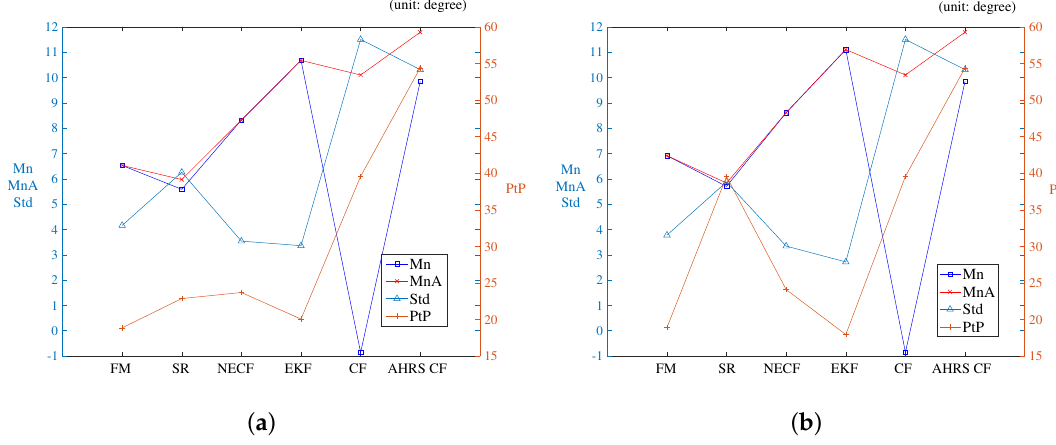
Figure 5. Average, average absolute error, standard deviation, and peak to peak of attitude error obtained with considered methods in experiment 1. ( a ) bias compensated; ( b ) bias not